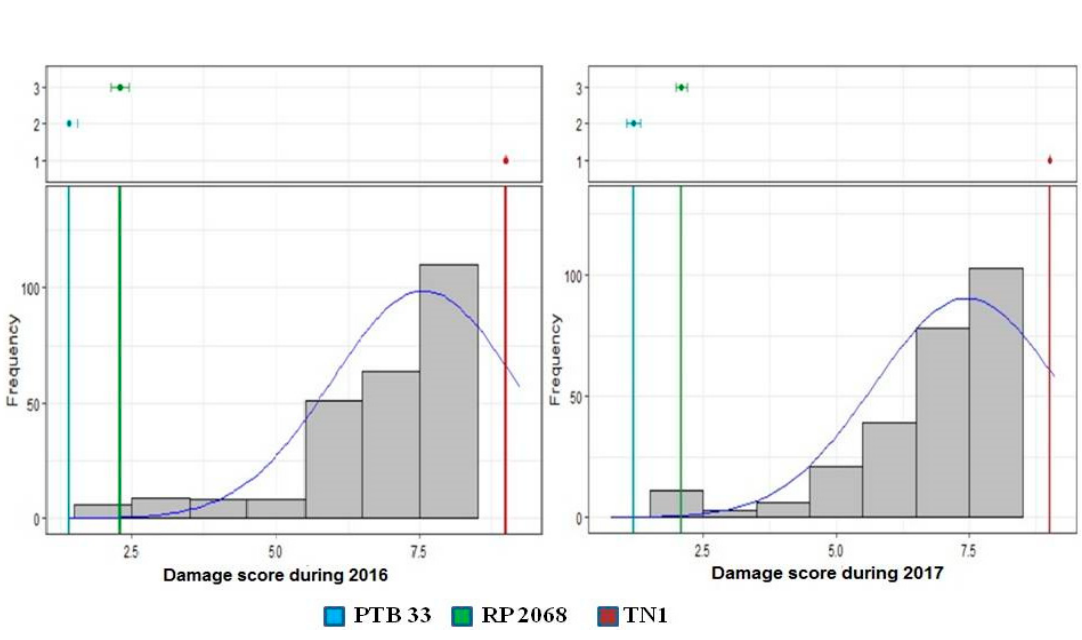
Figure 2. Histogram representation of frequency distribution of adjusted BPH scoring values of the RiMi panel. Top panel showing the performance of the checks as coloured lines in the histogram.